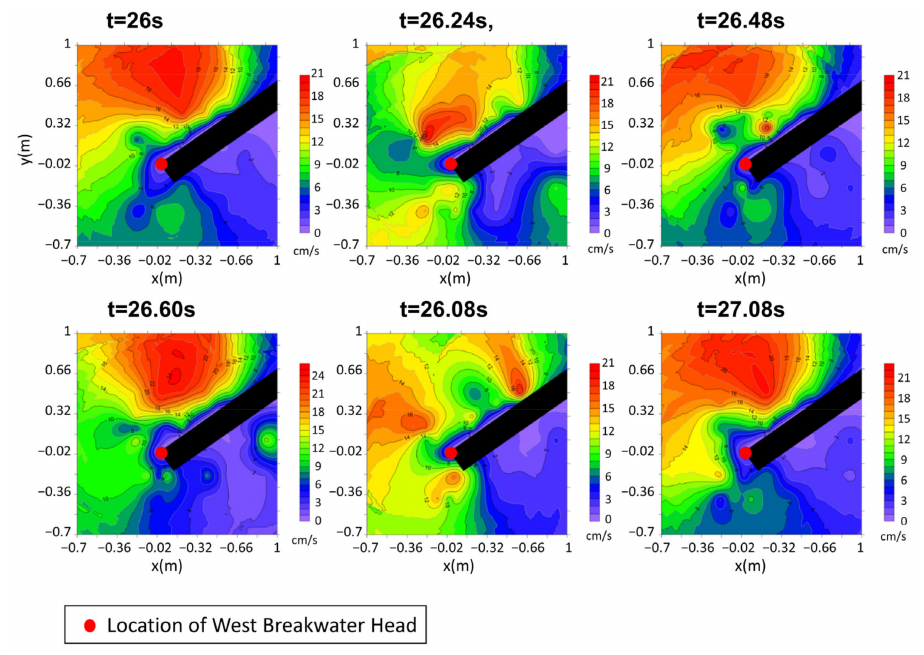
Figure 26. U around the West Breakwater under the action of typhoon waves (z = − 15 m). The distance between the two is about half a wavelength, so it can be inferred that one is a peak and the other is a trough. In the selected measurement time, the spatial distribution of the maximum current velocity U of each water layer is drawn as shown in Figure 27. It can be seen from the figures that the overall trend is roughly the same, but the upper layer velocity is larger. In addition to the large current velocity, there is an area with high current velocity in the z = − 15 cm water layer on the west side of the breakwater head at x = − 0.5~ − 1 m, and there is also a large current velocity area in the z = − 8 cm water layer in the southwest corner of the breakwater head.